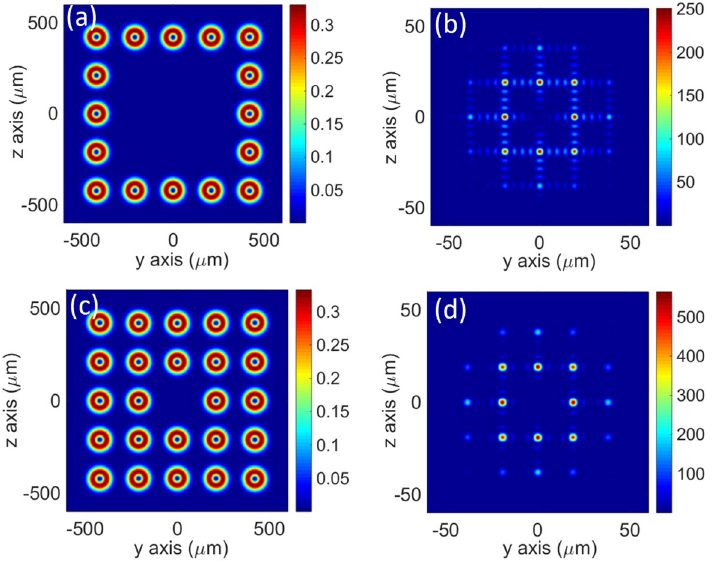
Figure 6. Numerical results when the number of the incident sub beams N = 16, 24. The peak intensity I 0 of the sub-beams is set to 1 at the waist plane x = 0. ( a ), ( c ) Intensity distributions of the sub-beams at the source plane x = − 4 mm when N = 16, 24, respectively. ( b ), ( d ) Intensity distributions of vortex light combined field at the waist plane x = 0, when N = 16, 24,